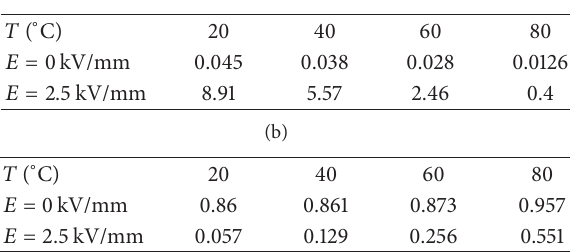
Table 2: (a) Values of the consistency index, 𝐾 [8]. (b) Values of the exponent, 𝑛 1 [8].